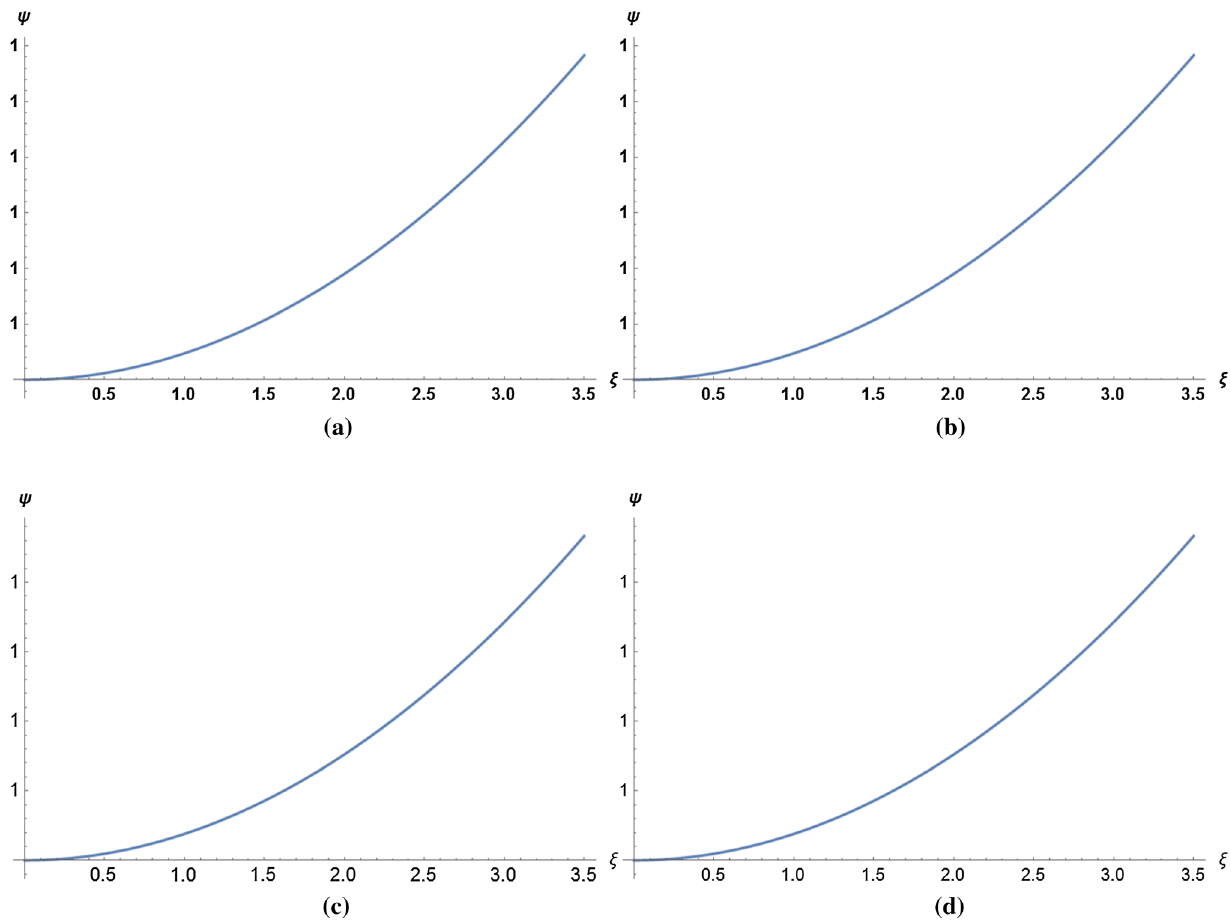
Fig. 5 Graphs between ξ and ψ ; for α 1 = . 5, n = 1 and α = 10 − 10 (curve a ); α = 2 × 10 − 10 (curve b ); α = 4 × 10 − 10 (curve c ) and α = 8 × 10 − 10 (curve d